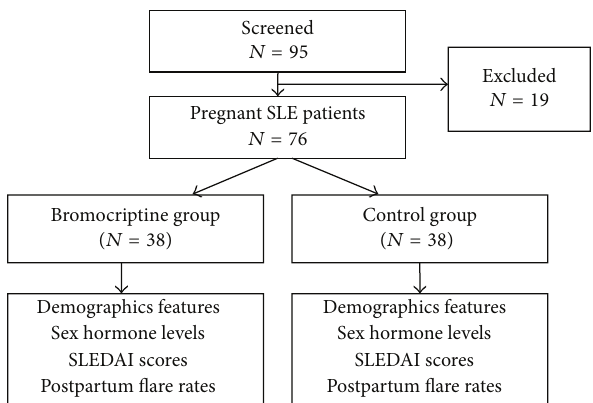
Figure 1: Study design. SLEDAI: systemic lupus erythematosus disease activity